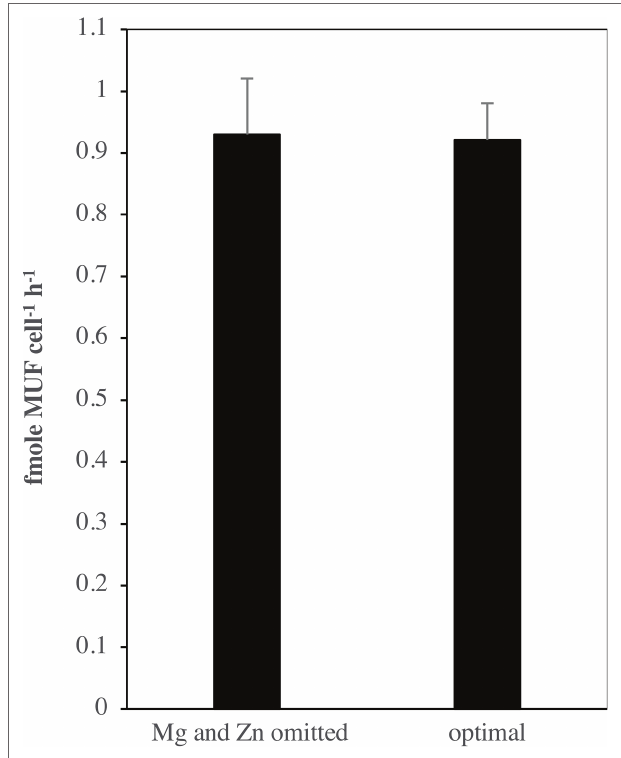
FIGURE 3 | End point assay measurement of alkaline phosphatase activity (APA) under Mg/Zn omission compared with optimal condition. Values are the mean, and the error bar is the spanning range between the two duplicate